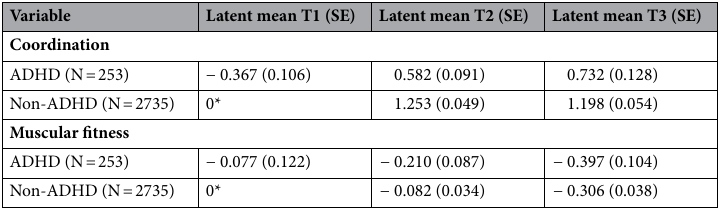
Table 3. Latent means for non-ADHD group vs. ADHD group (based on the scalar multigroup model with partial scalar constrains over time). *This value was constrained to 0 as a reference value for the estimation of all other latent means in the following time points as well as the latent means in the ADHD group. ADHD attention deficit hyperactivity disorder, SE standard error.